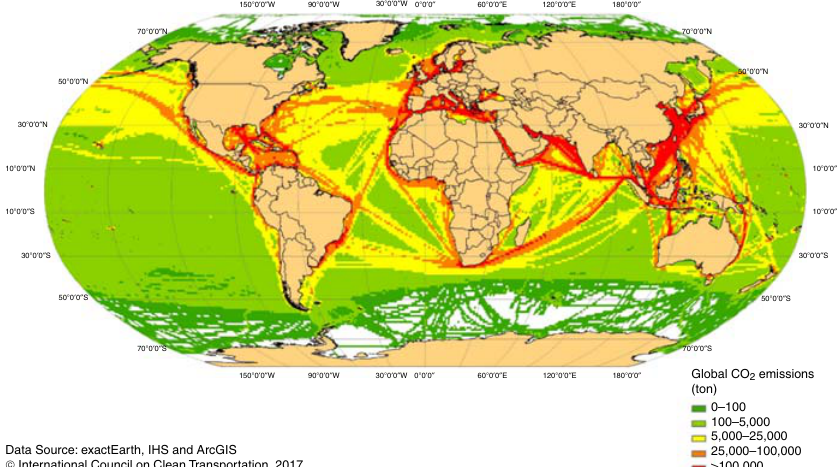
Figure 4. Global CO 2